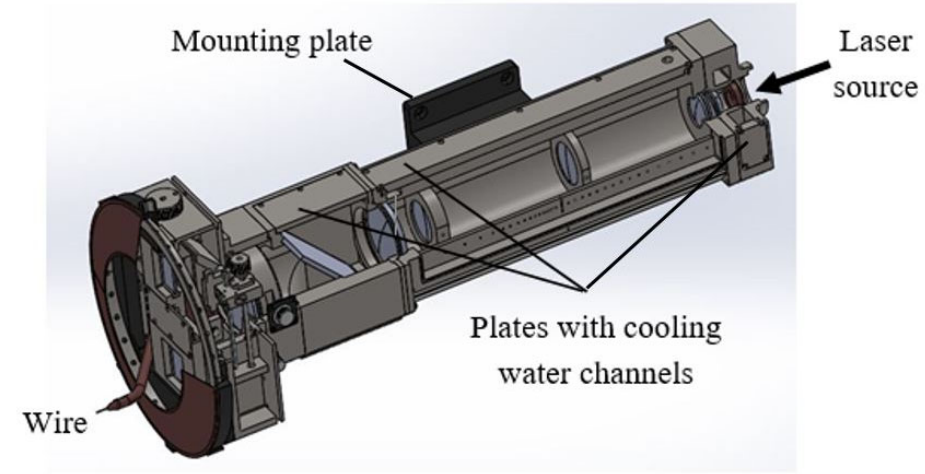
Figure 1. Geometric model of the developed optical laser head.